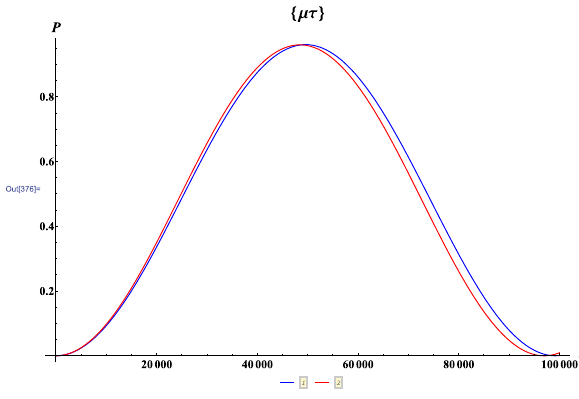
Fig. 9 Percentage variations induced in the neutrino oscillation prob- abilities by the LIV corrections. On the vertical axis we report, as a function of the baseline L, the percentage differences between the oscil- lation probabilities, for a 100 GeV neutrino, in presence and in absence of LIV, normalized with respect to their average value. The 3 different curves correspond to the percentage differences for the 3